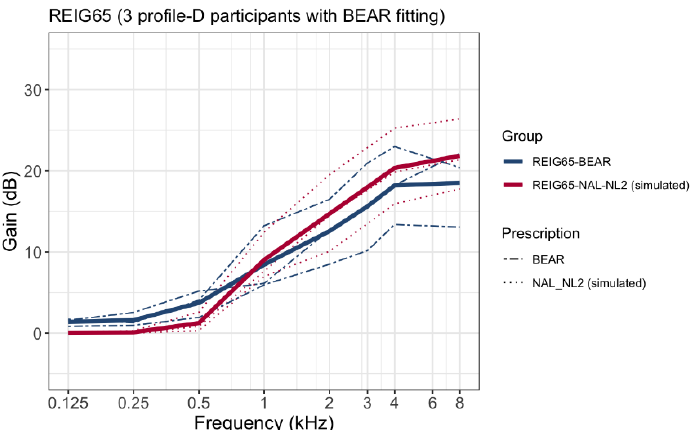
Figure A1. Mean REIGs at 65 dB SPL averaged across ears for three profile-D participants according to the BEAR strategy (blue lines). The red lines show calculated NAL-NL2 target gains.